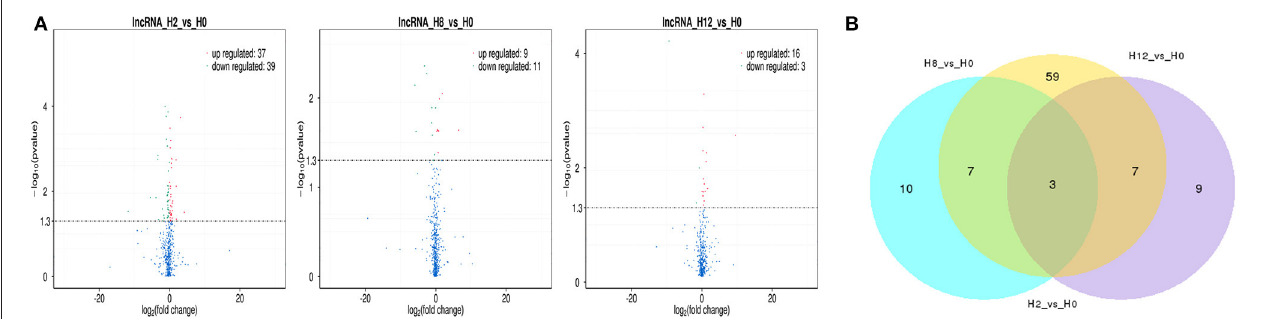
FIGURE 3 | (A) Volcano plots of differentially expressed lncRNAs in the H2 vs. H0, H8 vs. H0, and H12 vs. H0 comparisons. The red and blue blots represent the significantly upregulated and downregulated DE-lncRNAs. (B) Venn diagram of the DE-lncRNAs in the three comparisons.